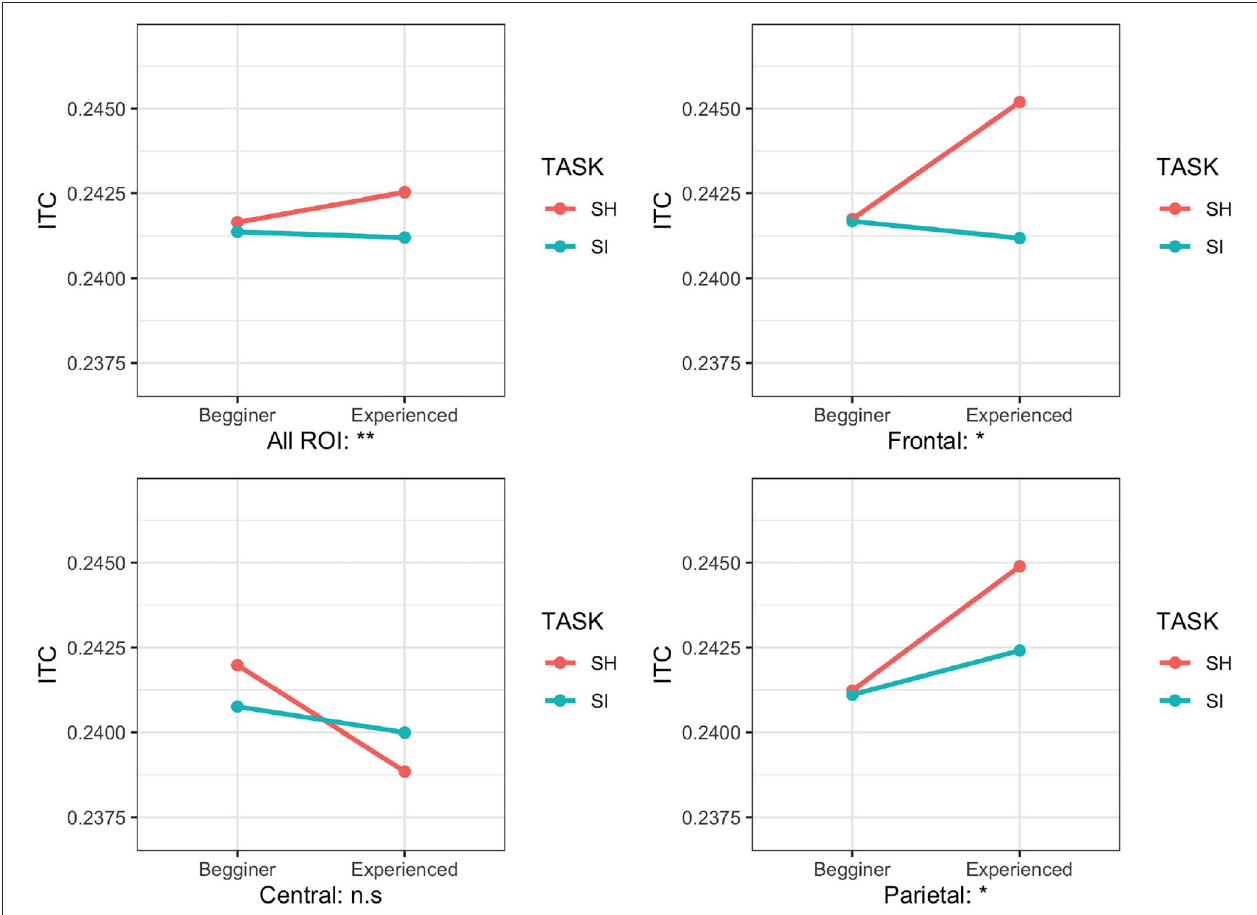
FIGURE 5 | Mean inter-trial coherence (ITC) values for different regions (all regions of interest [ROIs], frontal, central, and parietal) in two task conditions [simultaneous interpretation (SI) and simultaneous shadowing (SH)] and two groups (beginner group/B and experienced group/E). ** p < 0.01, * p <